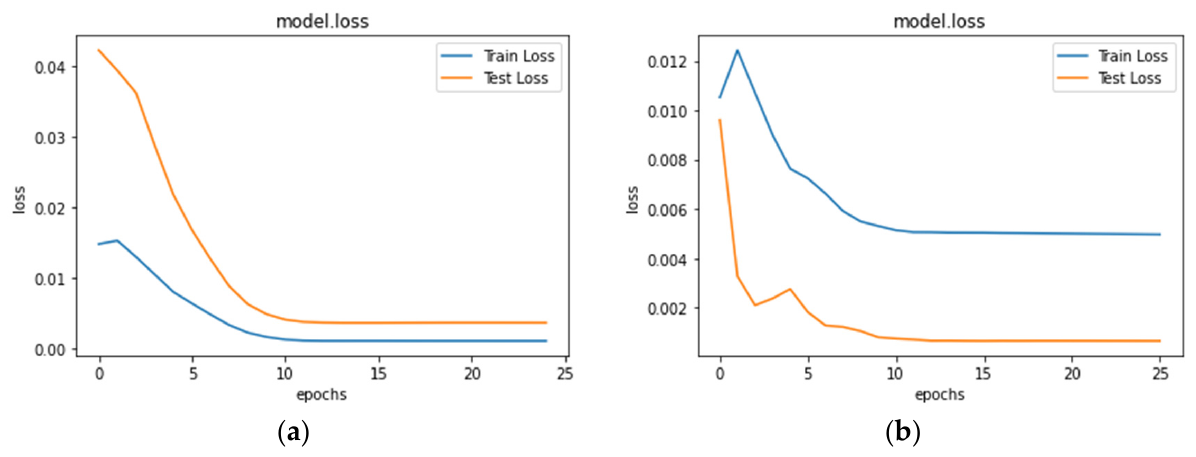
Figure 7. ( a ) Graph of loss function derivation for positive cases; and ( b ) graph of loss function derivation for death cases.